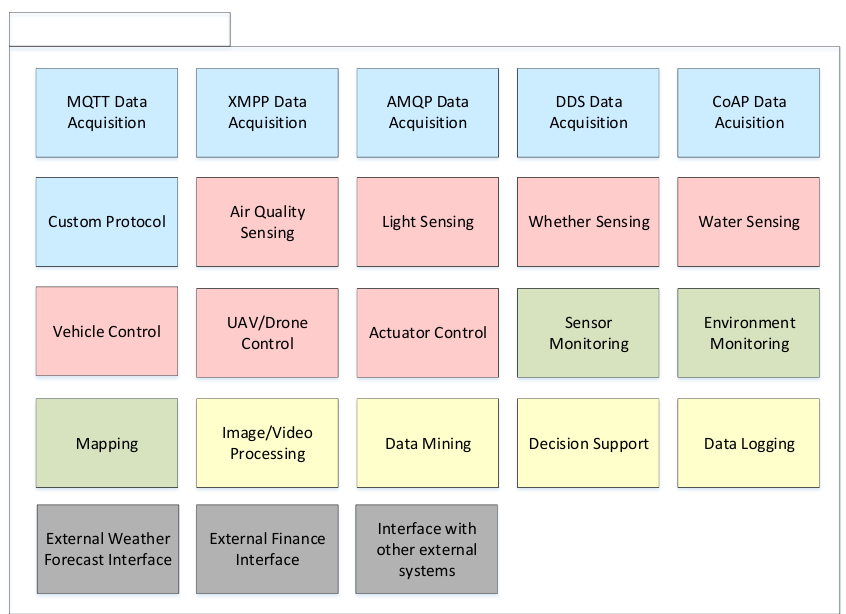
Figure 4. Reference Decomposition View for IoT-Based Smart City Inf. Man. Systems.